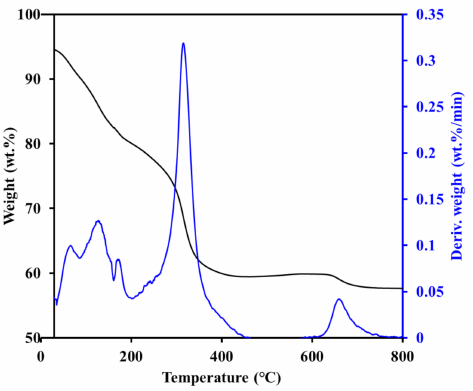
Figure 1. Thermogravimetric analysis and differential thermal analysis of the uncalcinated ZnTiO 3